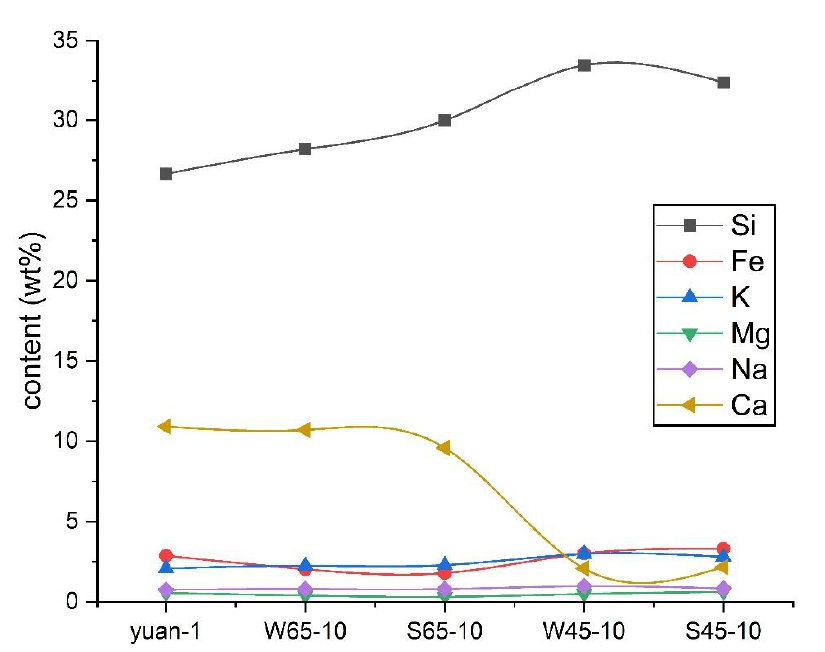
Figure 8. Comparison of major element content in ground rock specimens under different temper- ature